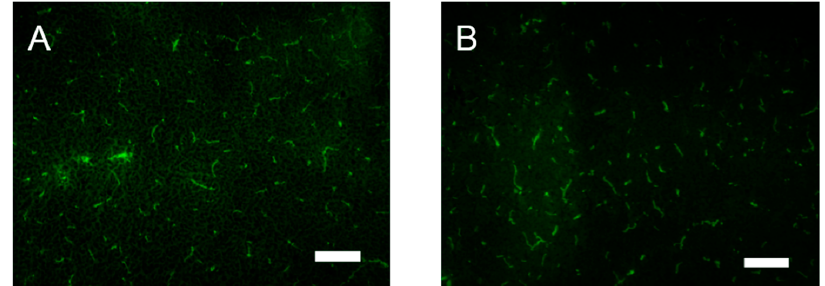
Figure 5. BBB permeability of AQP11-deficient mice was normal. After intracardiac perfusion of sulfo-NHS-biotin, the cerebrum was fixed with 4% paraformaldehyde. Cryosections of frozen tissue were labeled with Alexa-488-streptavidin (green). ( A ) Wild-type mice cerebral cortex; ( B ) AQP11-deficient mice cerebral cortex. Both did not show any leakage. The scale bars, 100 µm.